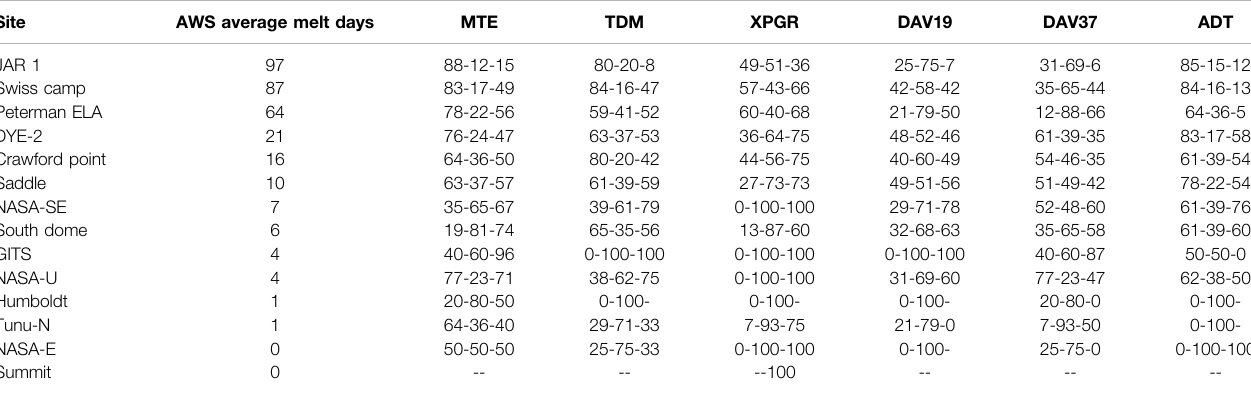
Average annual melt days are computed for the 2003 – 2007 record. The fi rst number in the comparison is the percentage of AWS de fi ned melt days correctly identi fi ed as melt in the microwaveproduct;themiddlenumberisthepercentageofAWSmeltdaysidenti fi edasfrozeninthemicrowaveproduct;thelastnumberisthepercentageofAWSfrozendaysidenti fi ed as melt days in the microwave